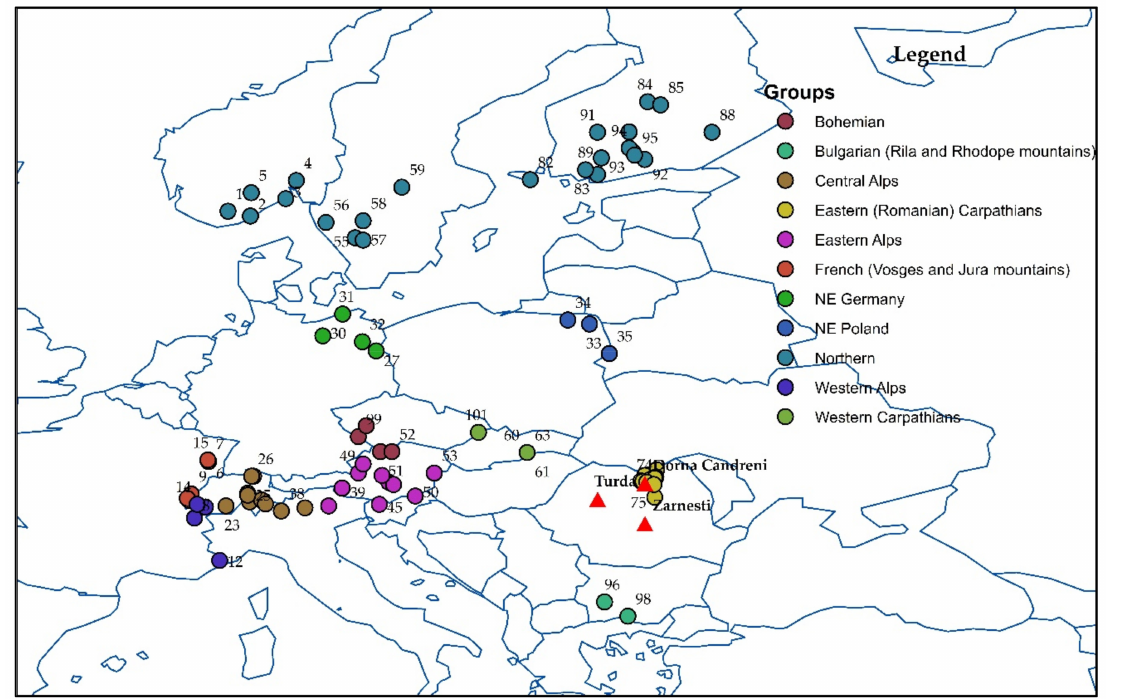
Figure 1. The locations of the Norway spruce provenances (dots and numbers) and of the provenance trials (red